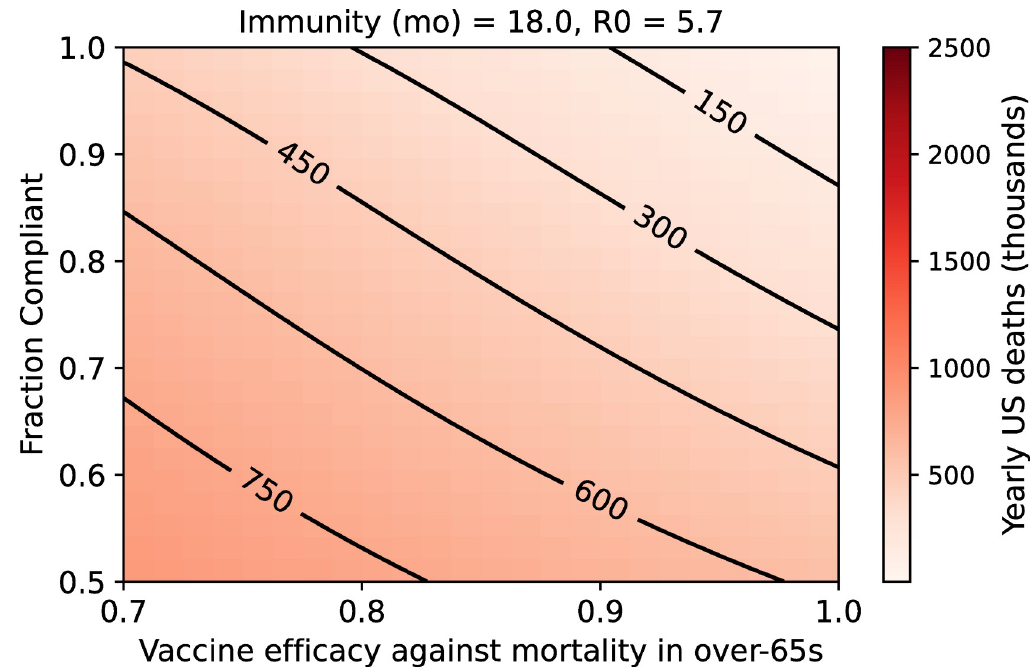
Fig 2. Range of mortality outcomes in the US population for a vaccine that reduces mortality risk by 95% in the under-65 population, and by varying degrees in the elderly. (Assumptions are: R 0 = 5.7, 18-month